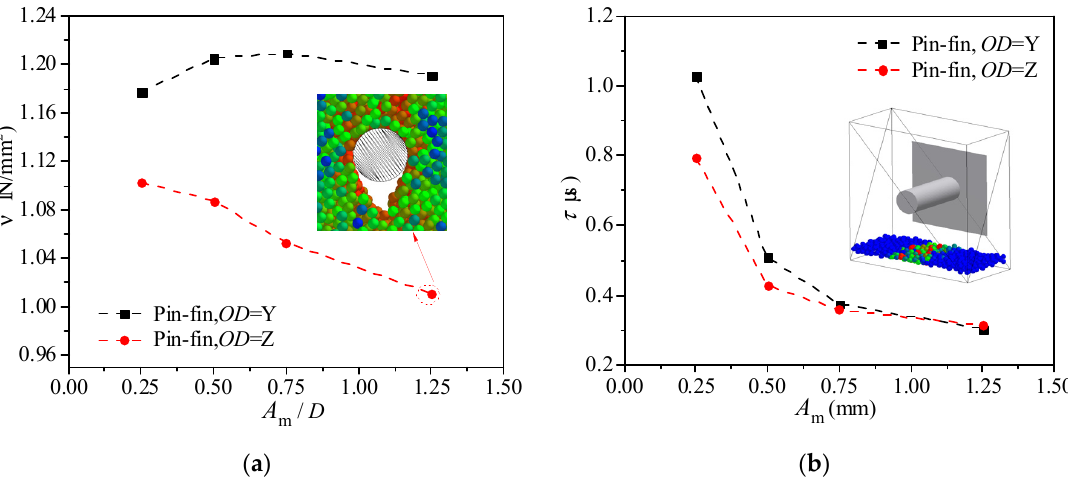
Figure 9. ( a ) Variation of the unit area particle contact number of pin-fin with the amplitude in different oscillating directions; and ( b ) variation of the contact time of particles with pin-fin with amplitude in different oscillation directions.